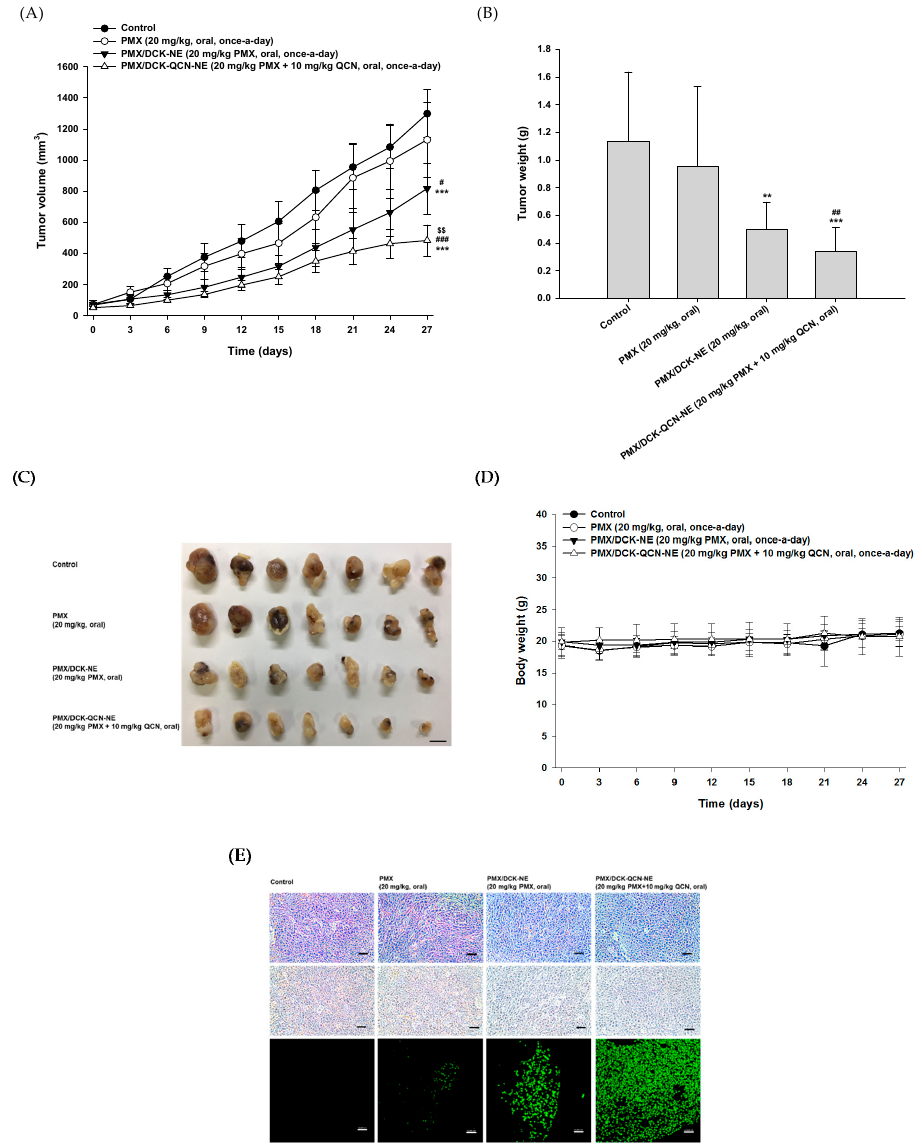
Figure 6. In vivo tumor growth inhibition efficacy in A549 tumor-bearing mice after treatment with once-daily oral administration of PMX (20 mg/kg), PMX/DCK-NE (equivalent to 20 mg/kg PMX), or PMX/DCK-QCN-NE (equivalent to 20 mg/kg PMX and 10 mg/kg QCN) for 27 days. ( A ) Tumor volume in mice ( n = 10; *** p < 0.001 compared with the control group; # p < 0.05, ### p < 0.001 compared with the oral PMX group; $$ p < 0.01 compared with the oral PMX/DCK-NE group); ( B ) Variation in body weight in mice during treatment ( n = 10); ( C ) Isolated tumor weight in A549 tumor-bearing mice ( n = 10; ** p < 0.01, *** p < 0.001 compared with the control group; ## p < 0.01 compared with the oral PMX group); ( D ) Photographs of isolated tumors from each group on day 21. Scale bar represents 10 mm; ( E ) Representative cross-sectional images of isolated tumor tissues stained with anti-CD31 antibody for microvessels (brown), PCNA for proliferating cells (brown), and TUNEL for apoptosis (green fluorescence) at 27 days after treatment. Scale bar represents 50 µm.